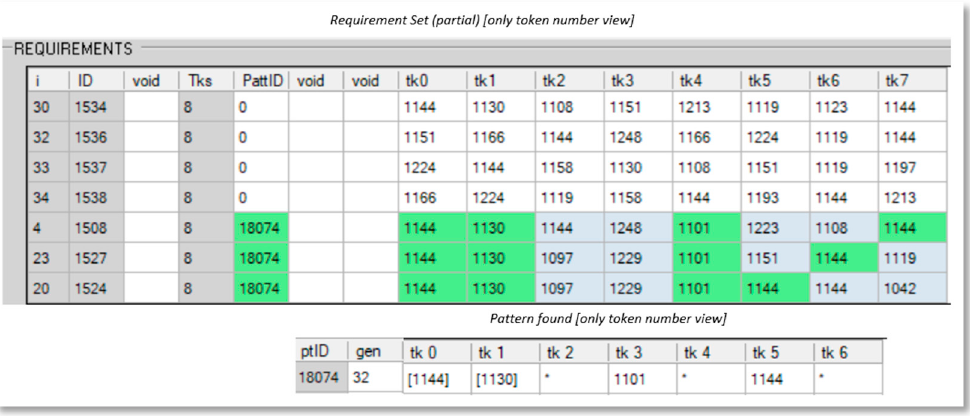
Figure 13. Snapshot of a real experiment using the software developed. This is the result of just one conquest iteration. Pattern ID 18074 matches Requirements Id 1508, 1527, and 1524 of the RS. Asterisks represent wildcard tokens as described in Section 3.1.5.